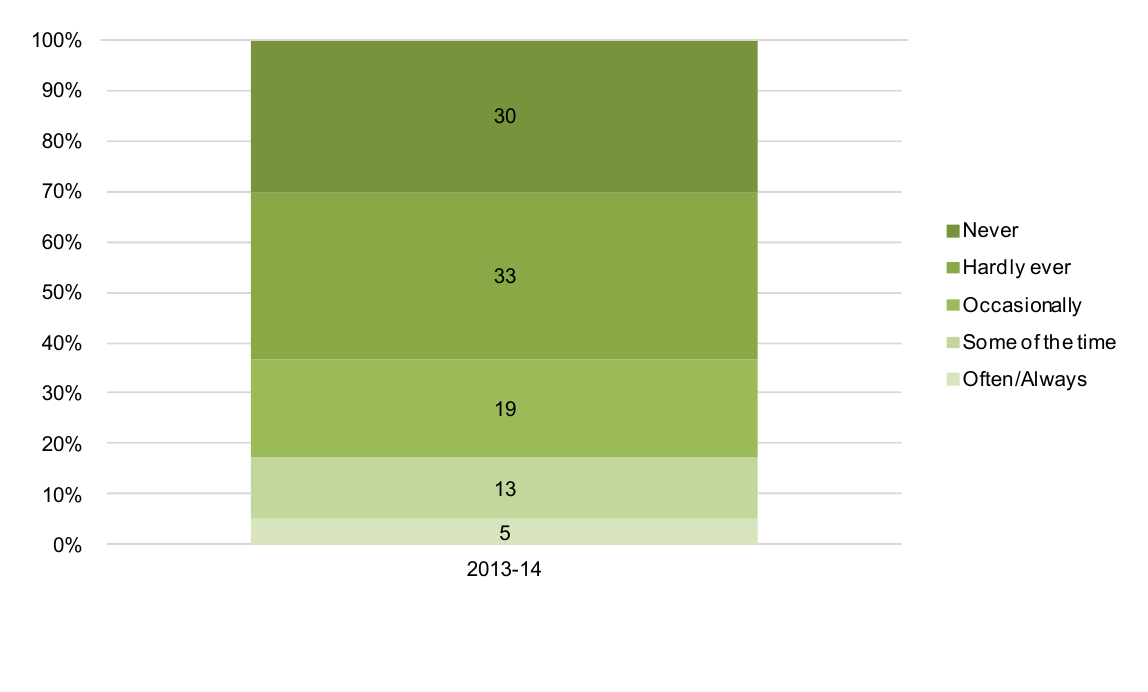
-Table 19: How often people felt lonely, 2013-14